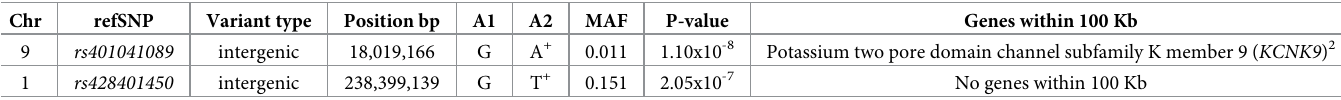
Table 1. Genome-wide significant single nucleotide polymorphisms (SNPs) associated with absolute monocyte